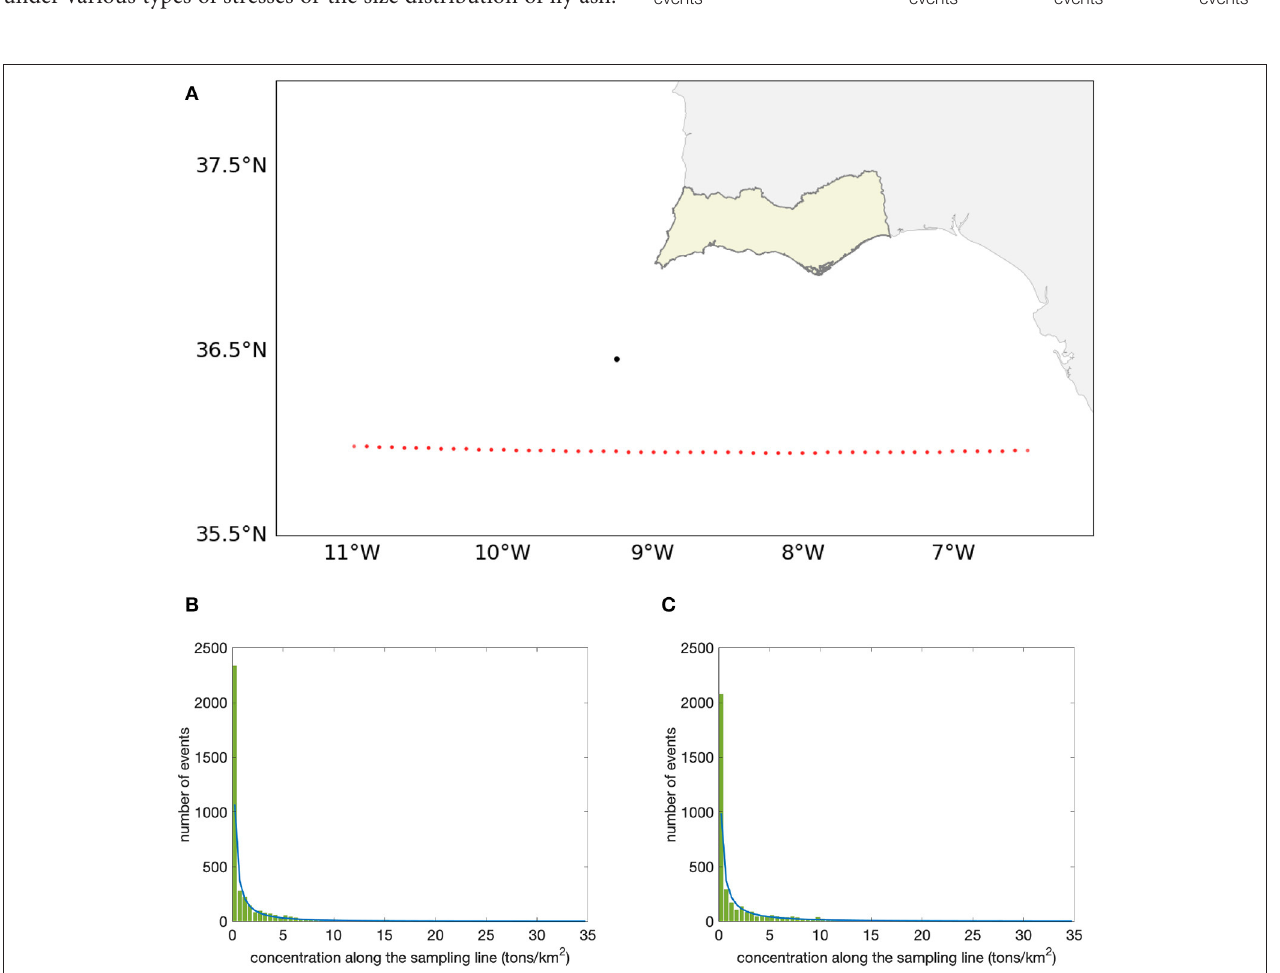
FIGURE 2 | (A) Map of the single release point (black dot) off the Algarve with the “sampling line” drawn in red dots. Histograms and Weibull function estimation for oil concentrations obtained at the “sampling line” (B) for the weathering experiment, which includes transport and weathering processes and (C) for the no-weathering